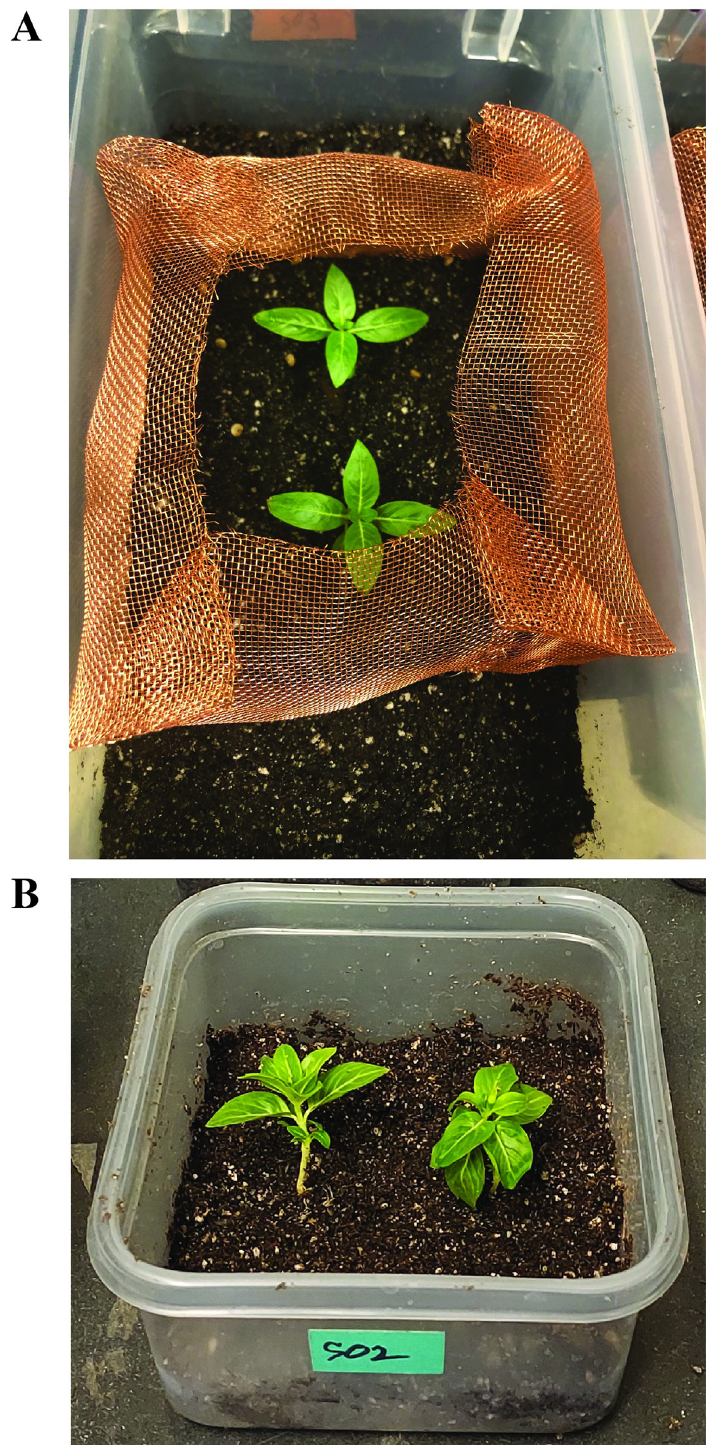
Fig 2. Treatment arena for determining the lethality of three US strains of Phasmarhabditis californica (ITD726), P . papillosa (ITD510), and P . hermaphrodita (ITD272) against (11.5-15mm/0.4–1.2 gram) Theba pisana at 5 times recommended dose of 150IJs/cm 2 (A) and for the dosage dependence of P . californica lethality against (11.5-15mm/ 0.5–1.3 gram) T . pisana at 30 IJs/cm 2 (Nemaslug 1 recommended dose) and 90 IJs/cm 2 (B).